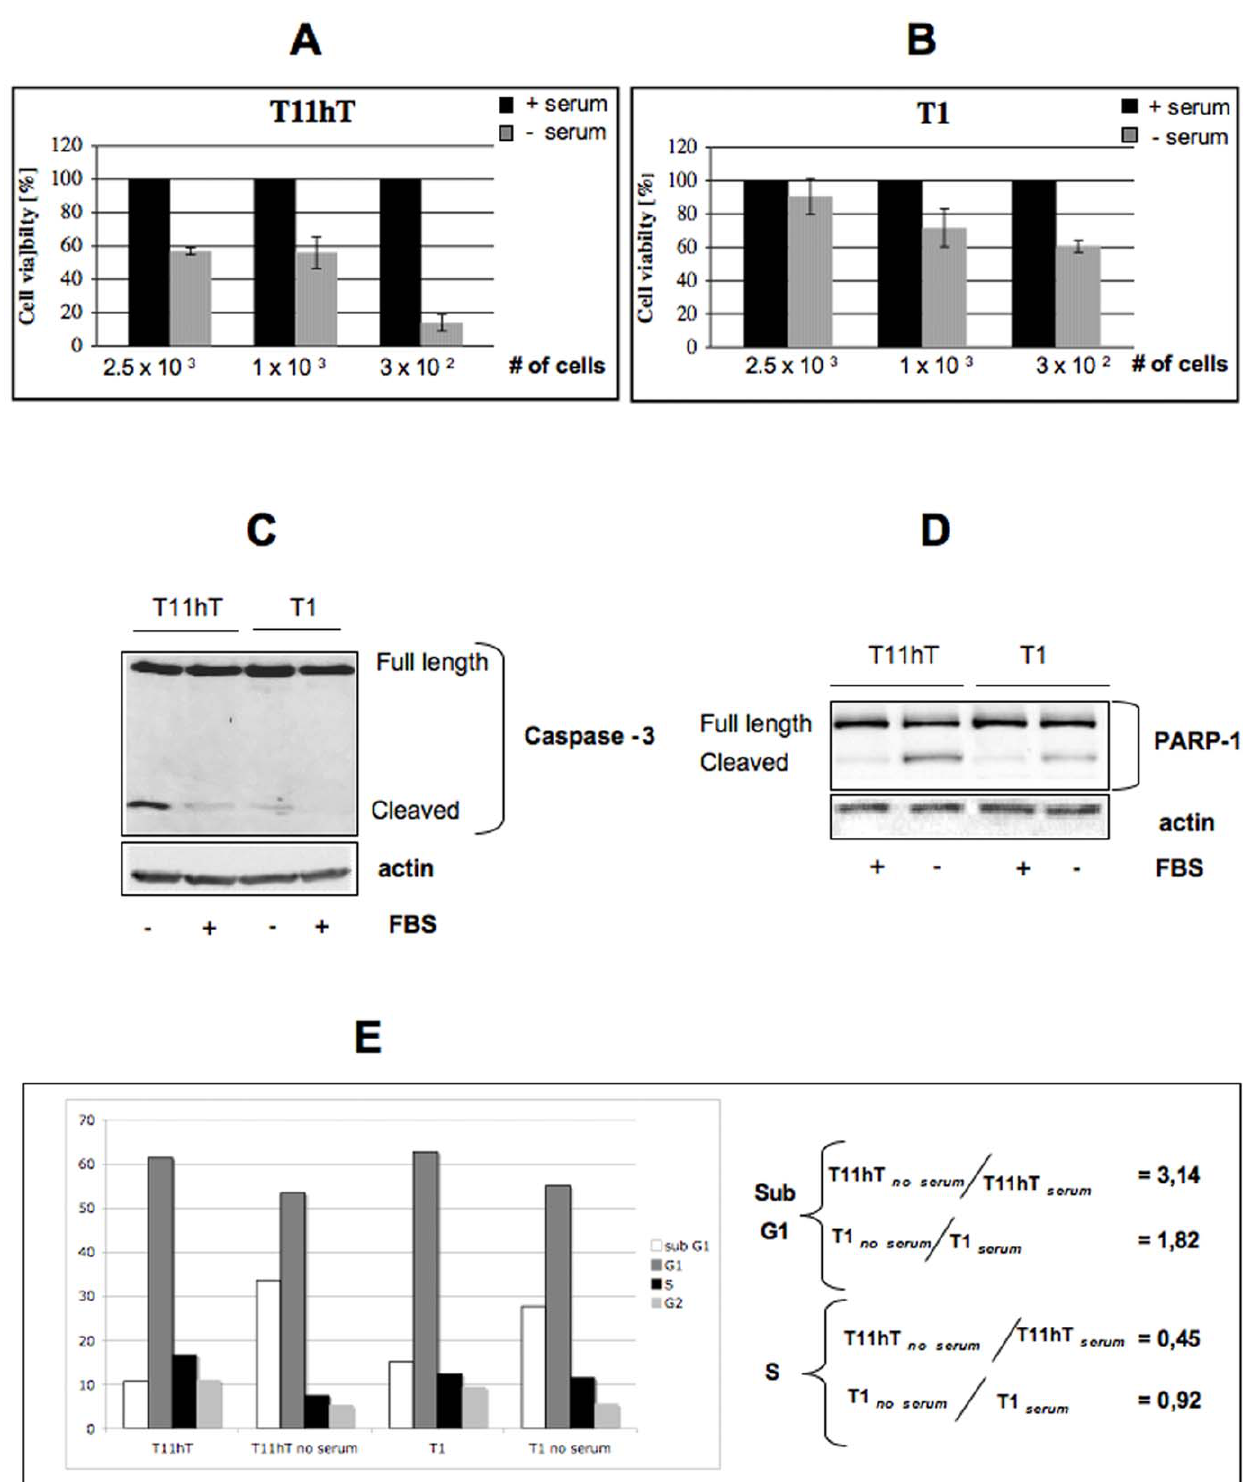
Figure 3. TBP-1 knockdown reduces sensitivity to serum starvation. A, B: Cells from the T1 clone and control cells (wt T11hT) were plated at different cell densities as indicated, either in the presence or absence of 10% FBS. After six hrs from plating, cell viability was measured by MTS assay. In the histograms, cell viability is expressed as relative to controls, arbitrarily set to 100 (%). The values are the mean 6 SE of three experiments performed in quintuplicate. C, D: 1.8 6 10 5 cells/35 mm plates from the T1 clone and control cells (wt T11hT) were grown for 24 hrs, in the presence or absence of 10% FBS. Apoptosis was checked by detection of Caspase-3 ( C ) and PARP-1 ( D ) cleavage in Western Blot. Detection with anti-actin was included for control of equal loading. Bands Intensity was measured by ImageQuant analysis on at least two different expositions to assure the linearity of each acquisition. Representative of at least four independent experiments. E: T11hT and T1 cells were counted and seeded at 2 6 10 5 cells/